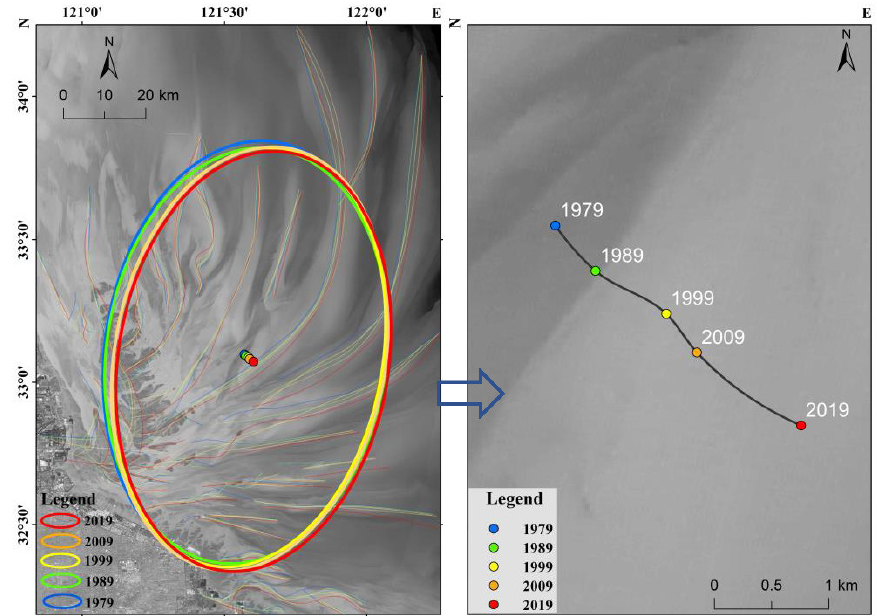
Figure 9. Ellipse and geographic center changes of the RSRs during 1979–2019. Table 3. Statistics of standard deviation ellipse parameter.